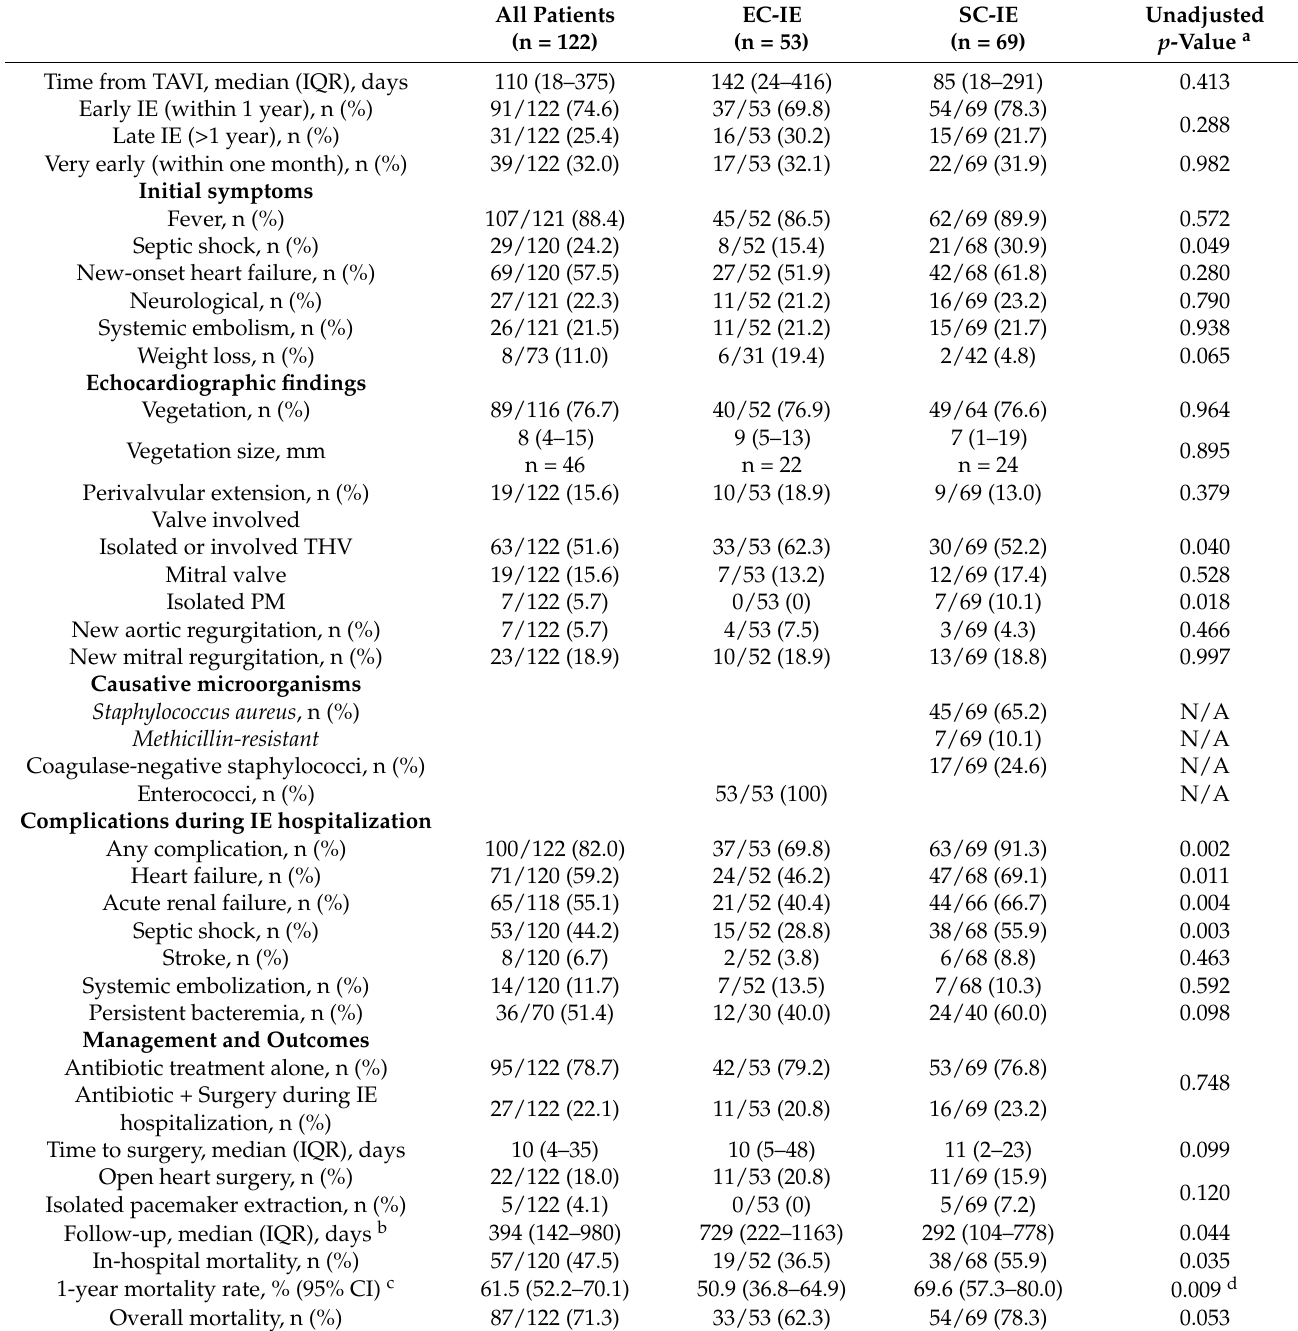
Table 2. Main clinical characteristics, management, and outcomes of IE